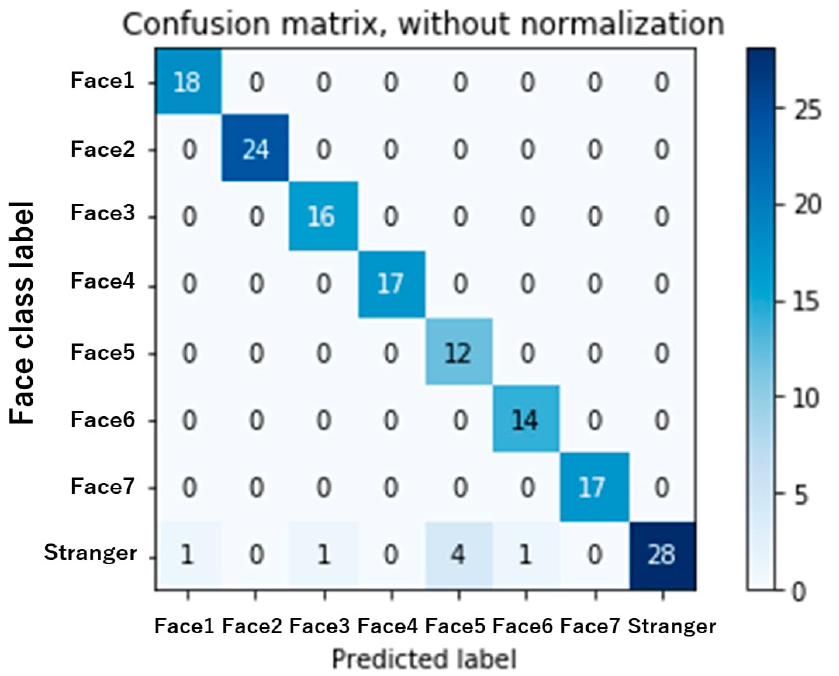
Figure 3. Confusion matrix for the multiclass classification face recognition model algorithm.